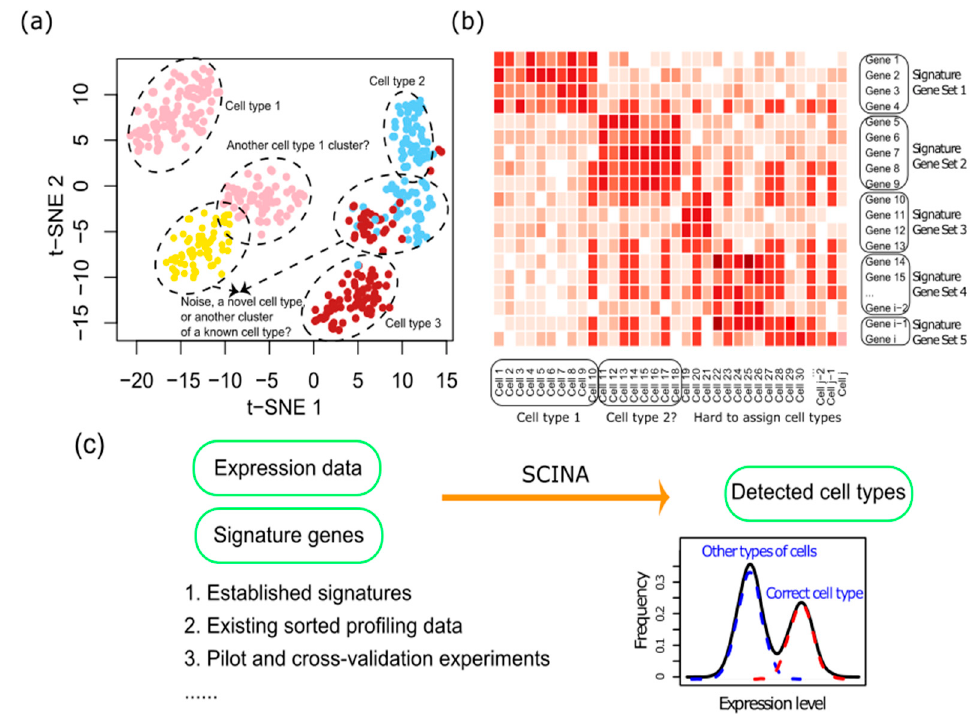
Figure 1. The Semi-supervised Category Identification and Assignment (SCINA) algorithm. ( a ) An illustrated t-SNE plot showing the problems often associated with discerning cell types based on clustering effect of t-SNE plots. ( b ) An illustrated heatmap showing the difficulties of manually assigning cell types based on signature genes when multiple signature genes are known for each cell type. ( c ) The rationale of SCINA. SCINA represent a supervised and automated approach for assigning cell types based on prior knowledge of signature genes and can directly arrive at detected cell types. The gene signatures could come from a variety of sources.